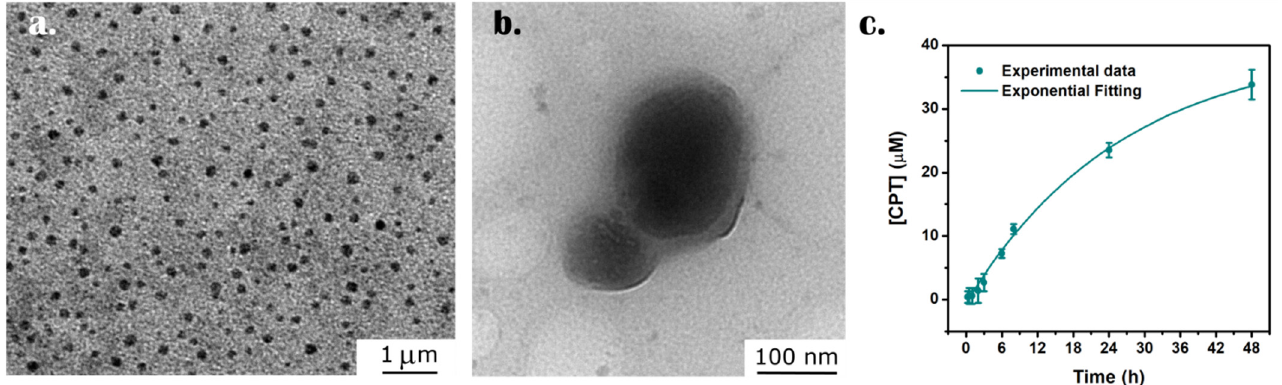
Figure 6. ( a ) Low magnification TEM image showing mostly monodispersed HNG-P(DEGMA-co- IA 12 ) nanoparticles. ( b ) High magnification TEM image of an isolated HNG. ( c ) Release study in PBS pH 7.4 and 40 °C.